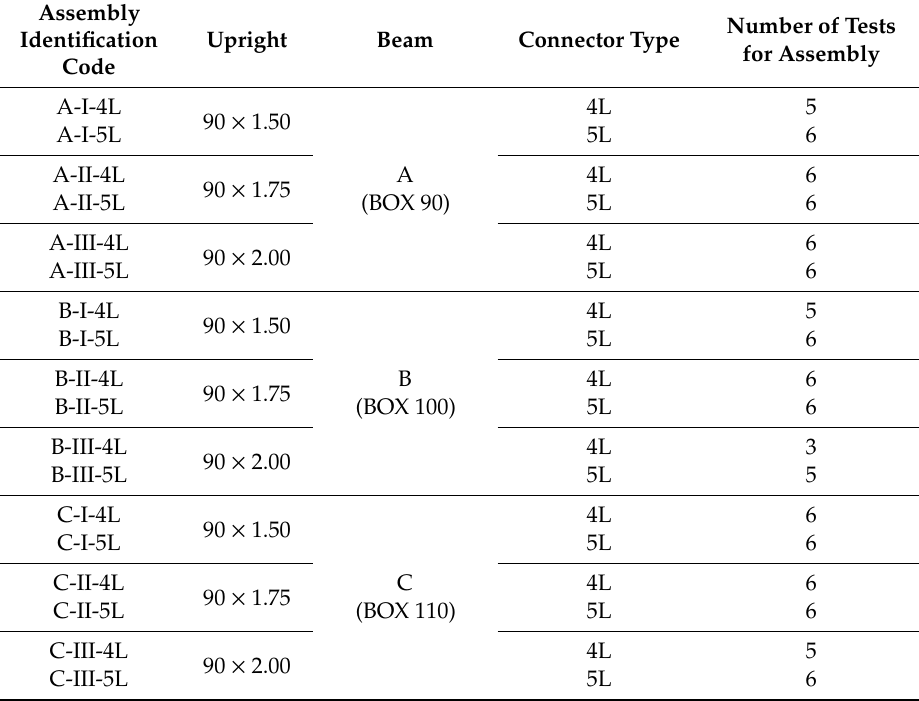
Figure 4. Shape and dimensions of the beam end connectors involved in the research (dimensions H, W, D are given in Table 3). Table 4. Upright-connector-beam assemblies